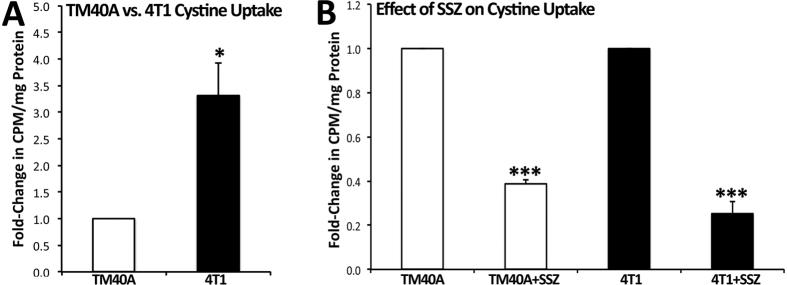
14C-cystine uptake assay on 4T1 cancer cells and TM40A mammary epithelial cells, both derived from BALB/c mice.(A) Cystine uptake by 4T1 cells was more than 3-fold higher than TM40A cells (P = 0.032). (B) 200 μM SSZ caused a decrease in TM40A cystine uptake to 0.39-fold (P < 0.001) and a decrease in 4T1 cystine uptake to 0.25-fold (P < 0.001). Results are represented as means from 3 experiments (performed in duplicates) ± SEM. Statistical significance was assessed through one-tailed Student t-tests. *P < 0.05. ***P < 0.001.